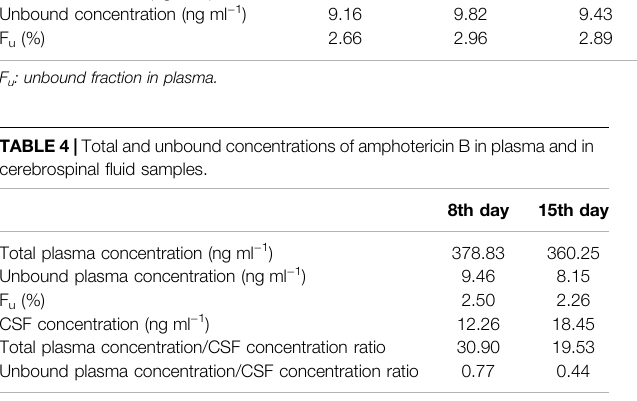
TABLE 3 | Unbound fraction of amphotericin B in plasma. The unbound concentration was determined in the last fi ve plasma samples comprising the terminal elimination phase. Phase 1 (4th day)